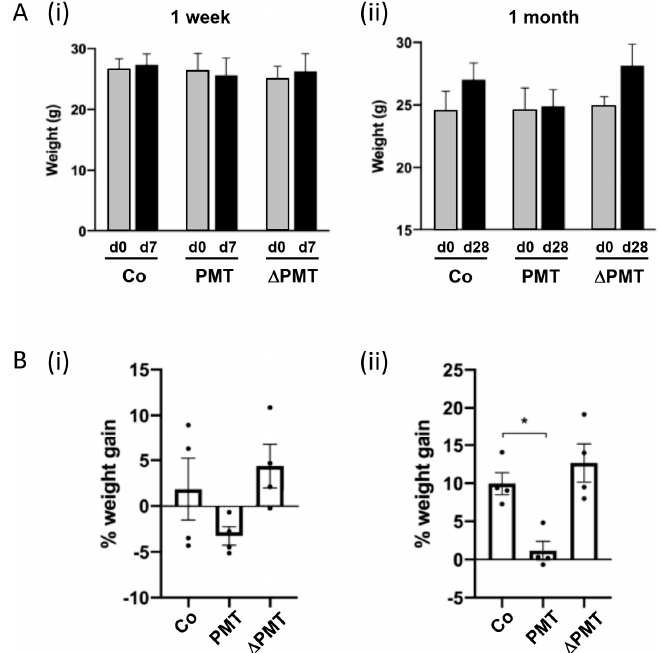
Figure 1. Pasteurella multocida toxin (PMT) treatment in vivo a ff ects weight gain. E ff ects of short-term and long-term treatment of PMT in mice in vivo. Mice were treated with 3 ng recombinant PMT, inactive mutant PMT ( ∆ PMT; 3 ng), or PBS vehicle (Co) for either one week or one month as indicated. Body weights were measured and depicted either as ( A ) actual weights from days 0 to 7 (A(i), 1 week) and days 0 to 28 (A(ii), 1 month), or ( B ) percent weight gain within the 1 week (B(i)) and 1 month (B(ii)) periods. The data represent the mean ± SD ( n = 4 per group) (* p < 0.05) (one-way